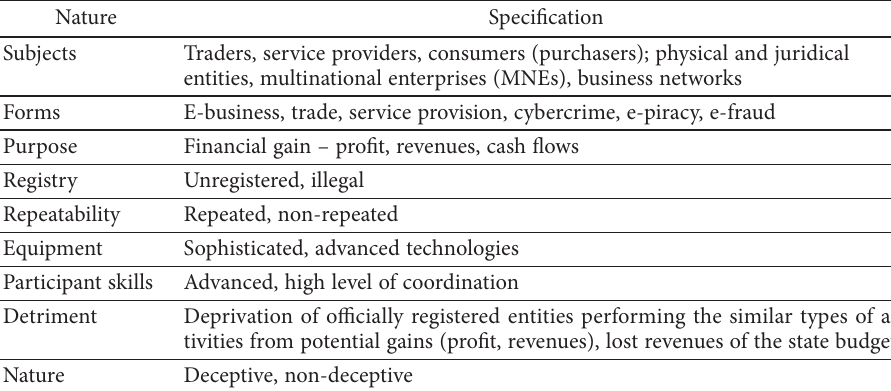
Table 2. Theoretical features of digital shadow